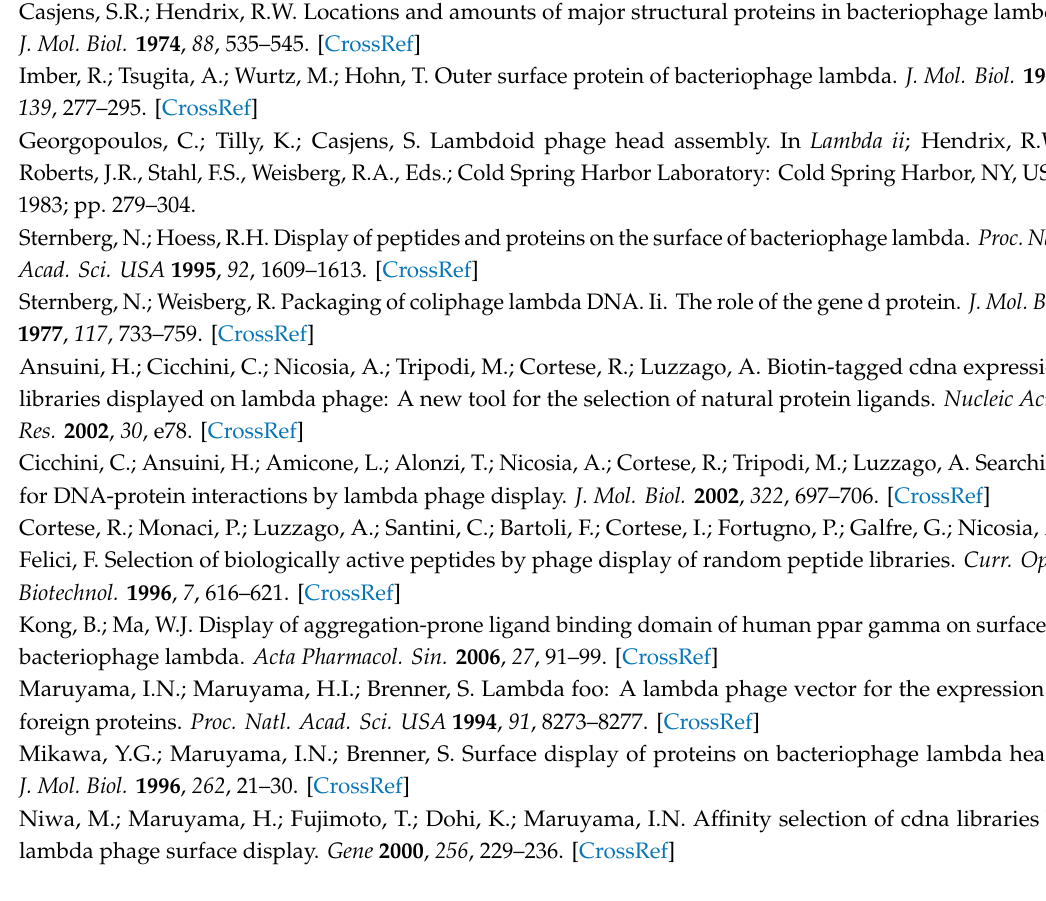
Figure S1: Coating lambda phage head with gpD or gpD-fusion proteins. Figure S2: Comparison of culture growth after gpD, gpD-LL37 and gpD-PR39 expression. Figure S3: Predicted disulfide bonds formed in D -fusion defensins. Table S1: Complementation by plasmid expression vectors of an amber mutation within the capsid decoration protein gpD in two lambdoid phages. Method for Single-burst LDP-vaccine and SEV production. Supplementary File S1: Single epitope vaccines (SEV): a hypothesis and approach using phage display particles made from bacterial virus